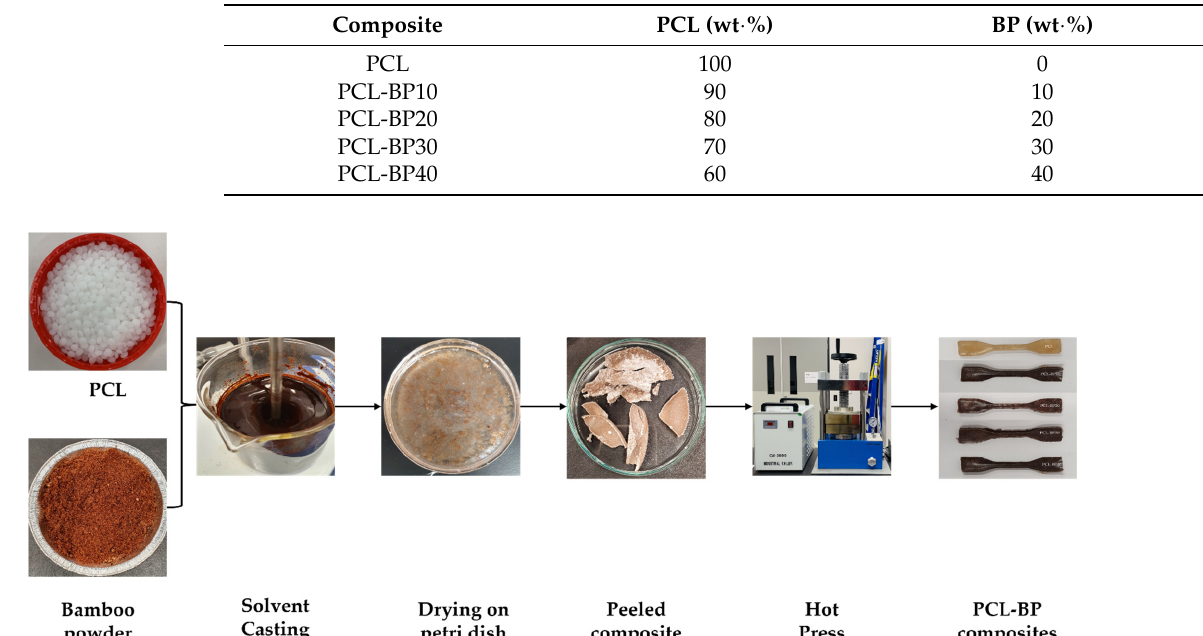
Figure 1. Illustration of the solvent casting of PCL and PCL-BP composites.